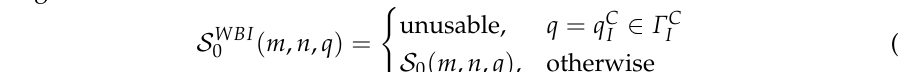
Figure 4. The MF results of ( a ) the non-interfered sub-pulse and ( b ) the interfered sub-pulse.